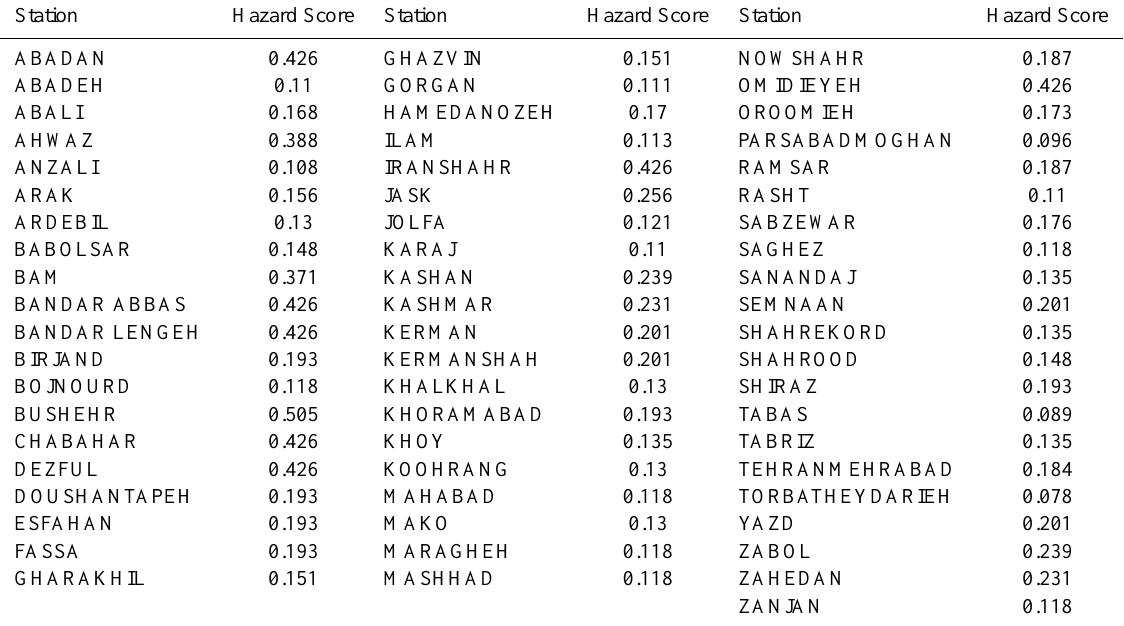
Table 6. The climatic hazard score of the studied stations.